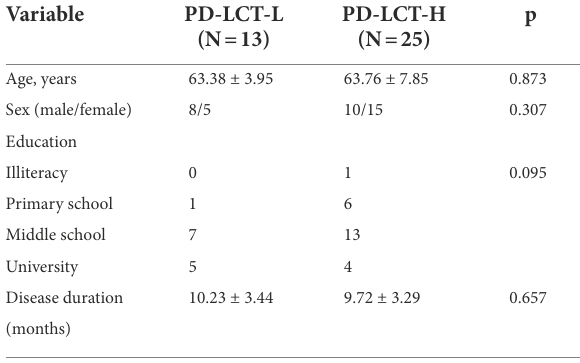
TABLE 1 Demographic and clinical characteristics of the study population.